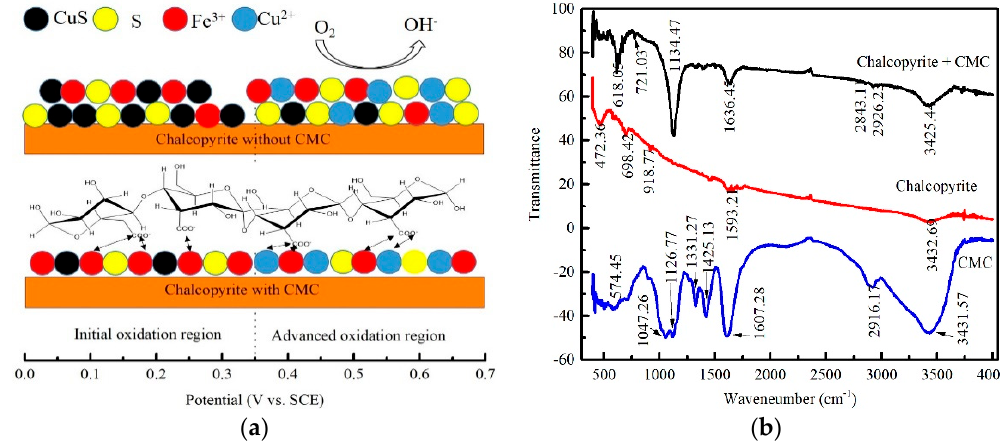
Figure 7. ( a ) Mechanism of the CMC ‐ inhibited electrochemical reaction of chalcopyrite; ( b ) FTIR spectra of chalcopyrite in the absence (black) and presence (red) of CMC, the CMC spectrum is shown in blue.